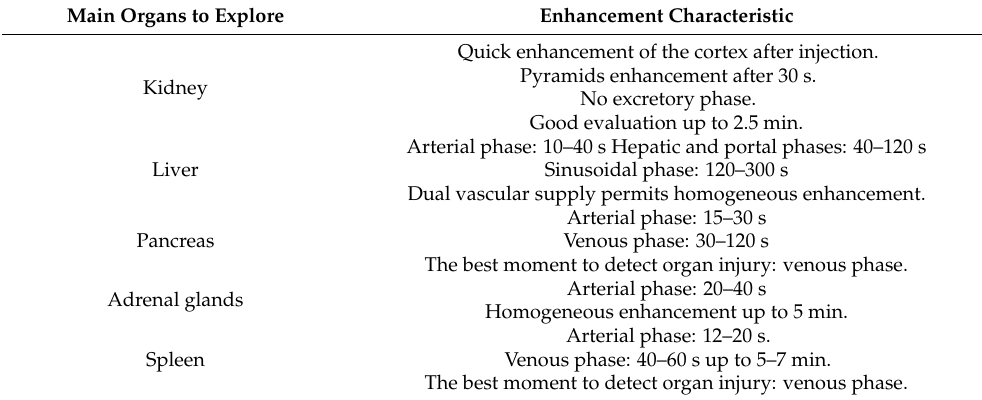
Table 2. Enhancement characteristic for organ with the best opacification